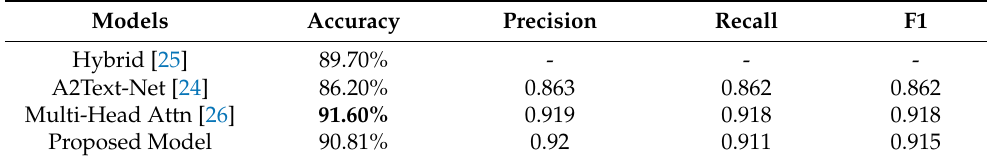
Table 4. Performance comparison of headlines dataset.